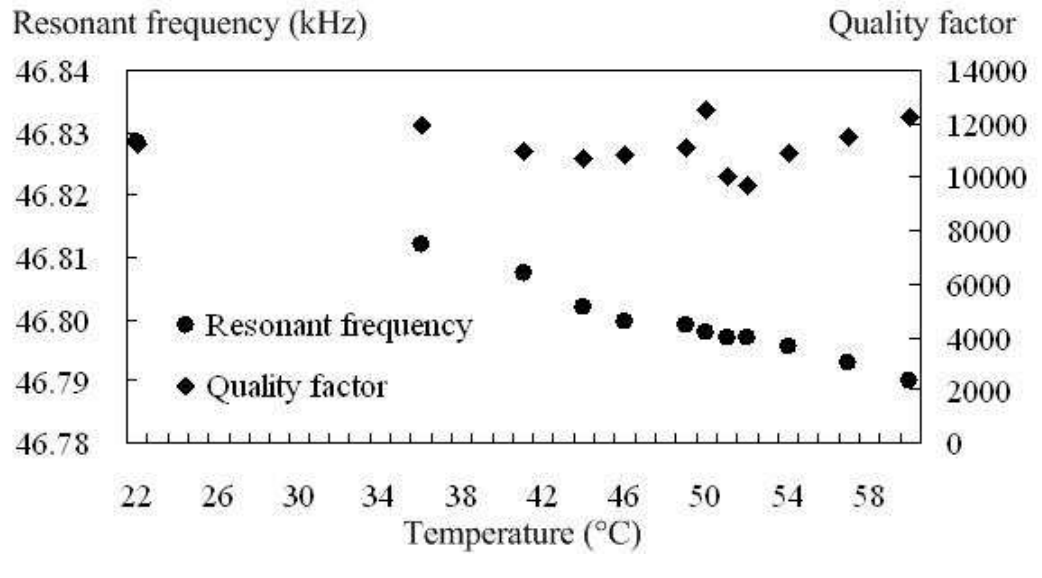
Figure 12. Plot of measured resonant frequency and Q versus temperature for Device D